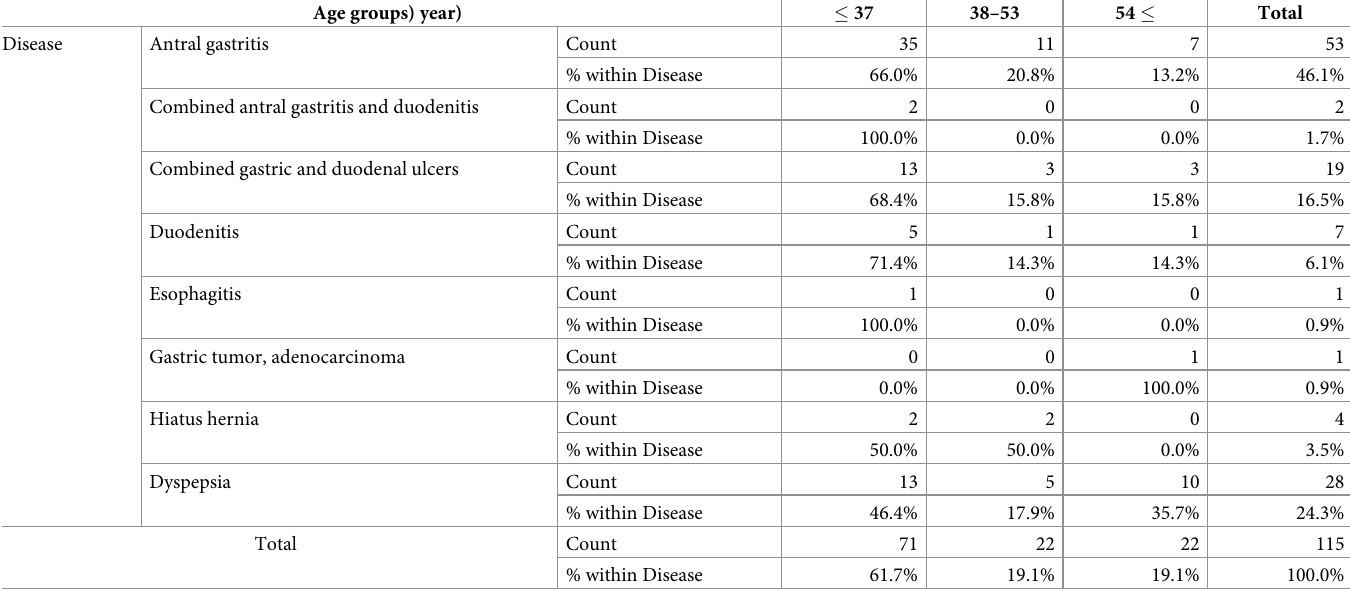
Table 2. The distribution of people with gastrointestinal disorders by age.